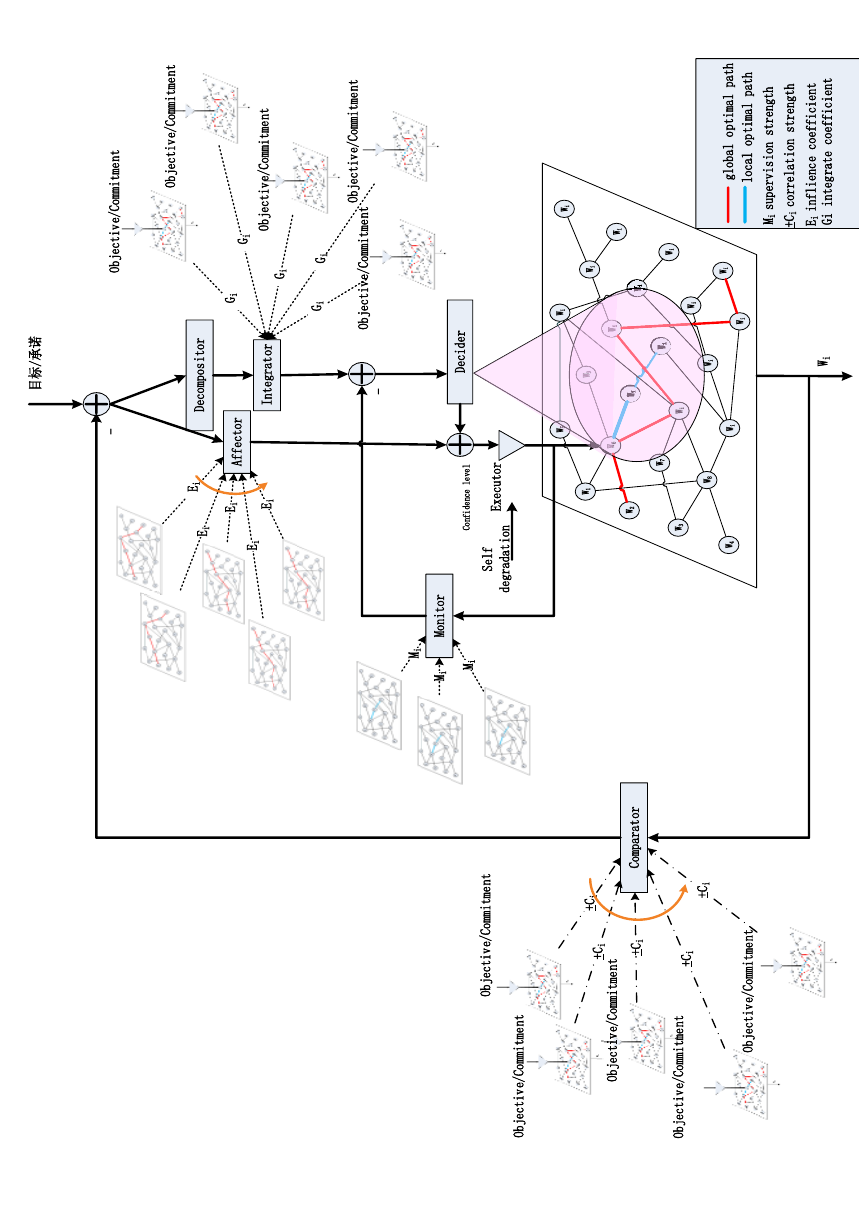
Figure 2. Collective unit of mind